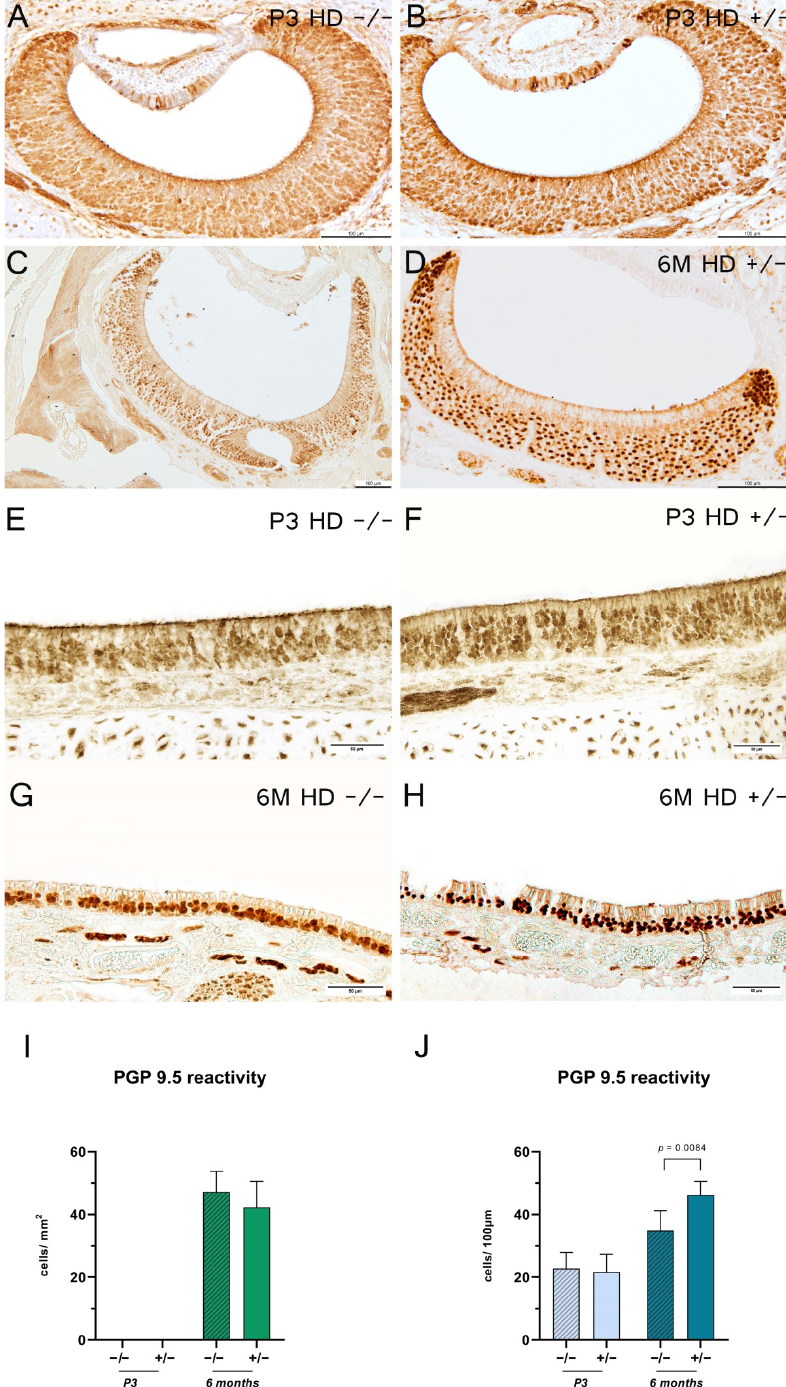
Figure 4. Protein gene product (PGP) 9.5 reaction for 3-day-old (P3) and 6-month-old (6 M) rats. ( A – H ) Representative immunohistochemical reaction of PGP 9.5-positive cells in the vomeronasal epithelium ( A – D ) and main olfactory epithelium ( E – H ). Scale bars: ( A – D ) 100 µ m; ( E – H ) 50 µ m. Column bars show PGP 9.5-reactive cell counts per mm 2 ( I ) or per 100 µ m ( J ); ( I ) P3 and 6 M: n = 5–6; ( J ) P3: n = 6, 6 M: n = 5. The significance of differences between groups was tested with